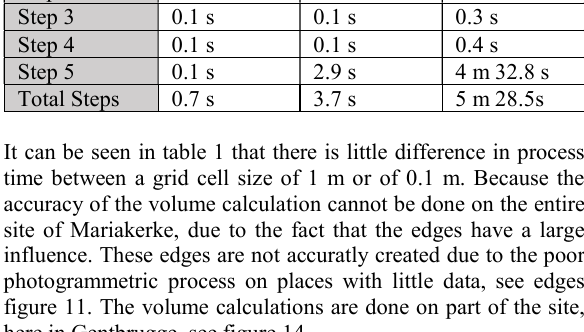
here in Gentbrugge, see figure